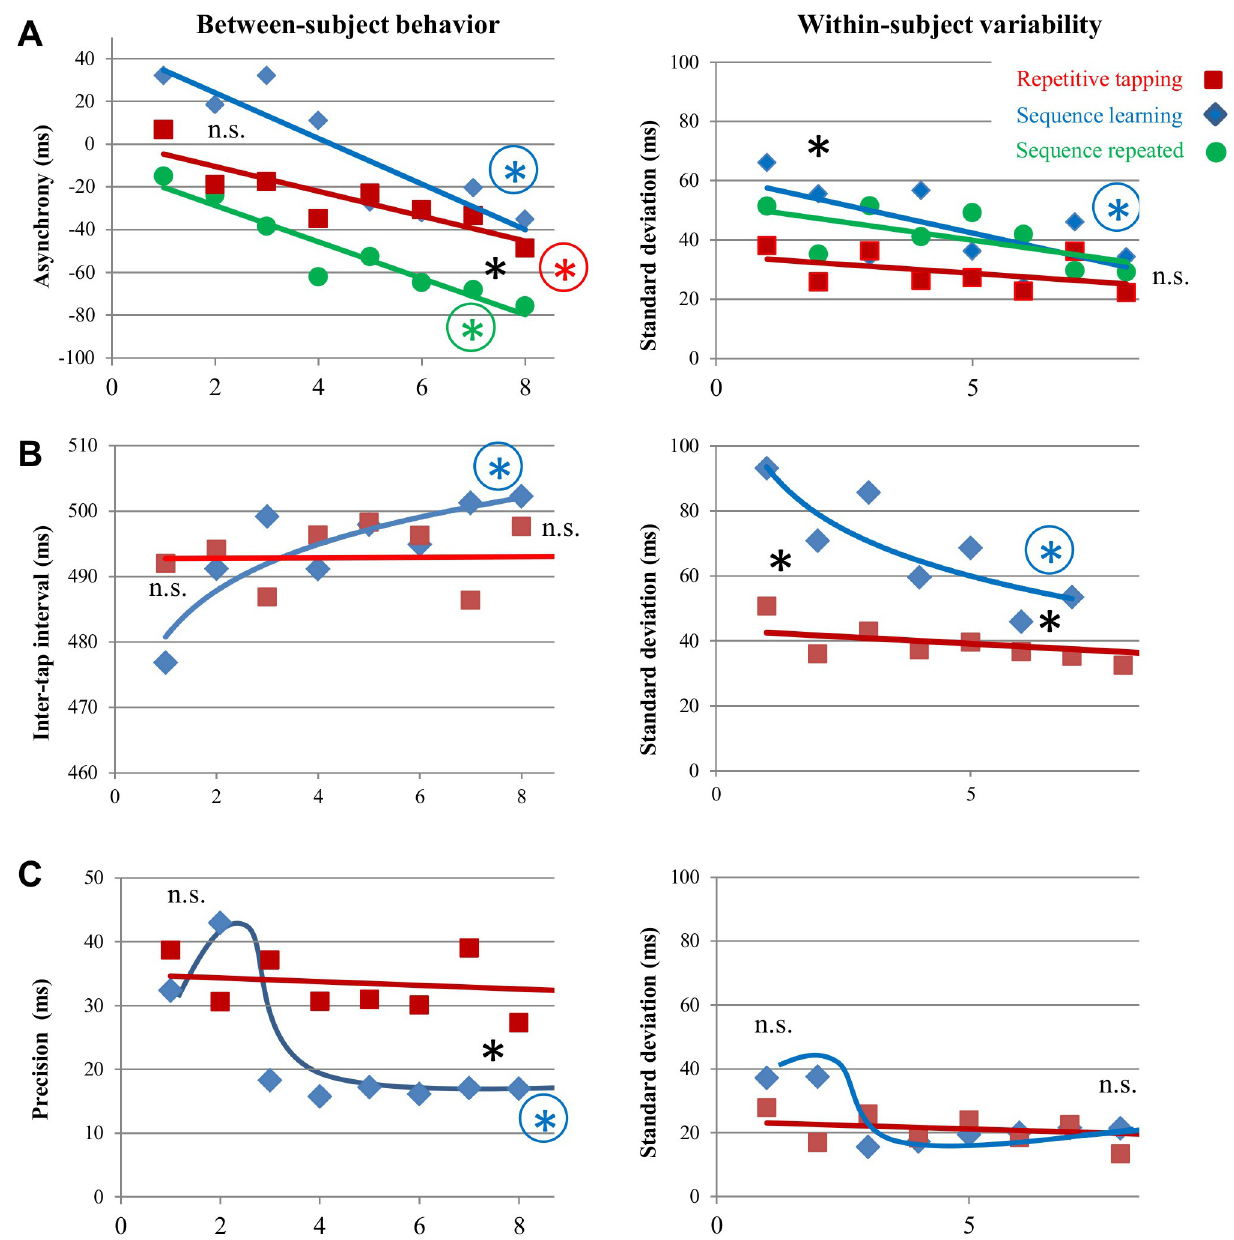
Fig 3. Rehearsal effects on motor performance during sequence learning and repetitive tapping. (A) Changes in stimulus-response asynchrony across rehearsals. Negative values for asynchrony represent anticipatory responses, which developed across rehearsals for all motor conditions; variability represents standard deviations for 4-note groupings among individuals. Colored encircled asterisks indicate a significant difference from the first to last pair of repetitions during a task; a plain black asterisk at the beginning or end of rehearsals indicates a significant difference between task conditions (p < 0.05). (B) A change in intertap intervals was observed across rehearsals only in the sequence learning task, accompanied by a decrease in variability. (C) A change in precision was observed across rehearsals only in the sequence learning